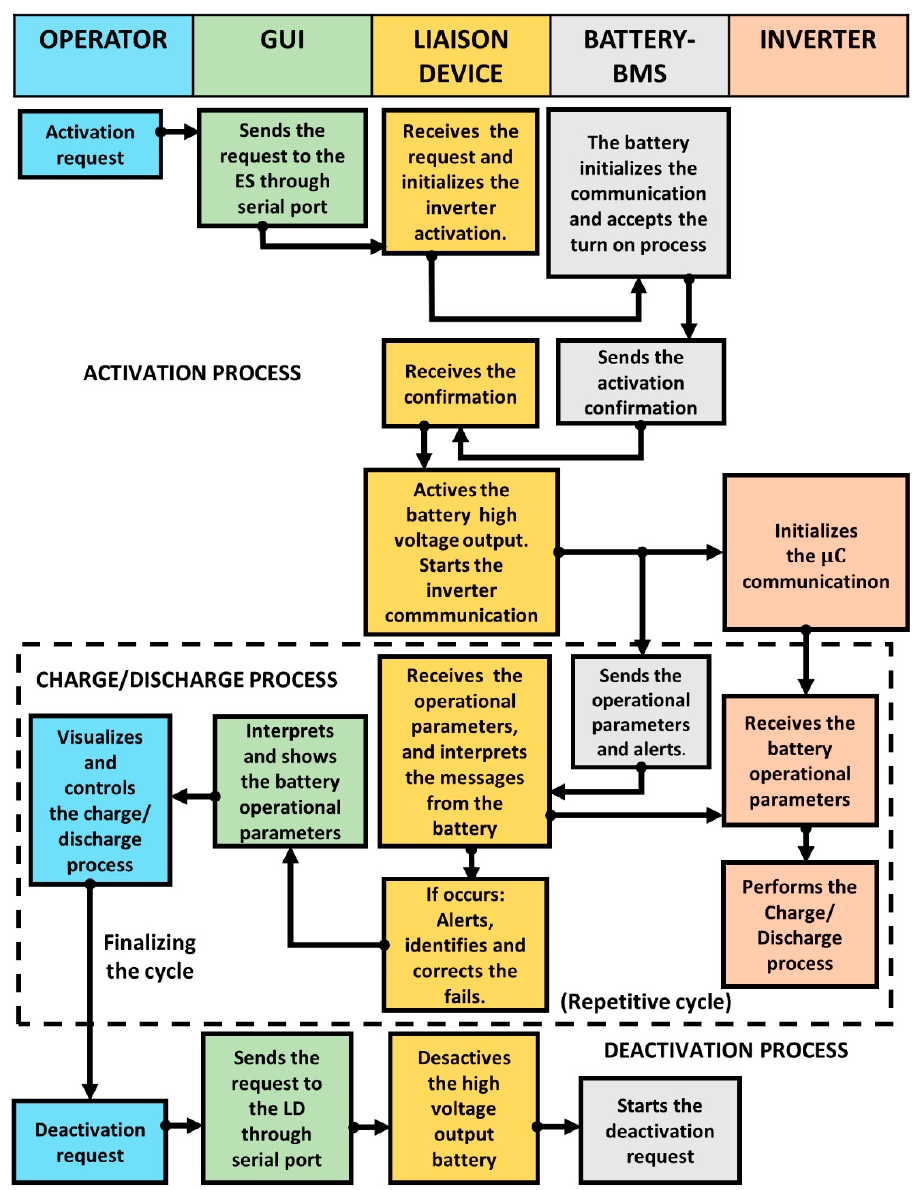
Figure 5. Flowchart describing the ES performance.